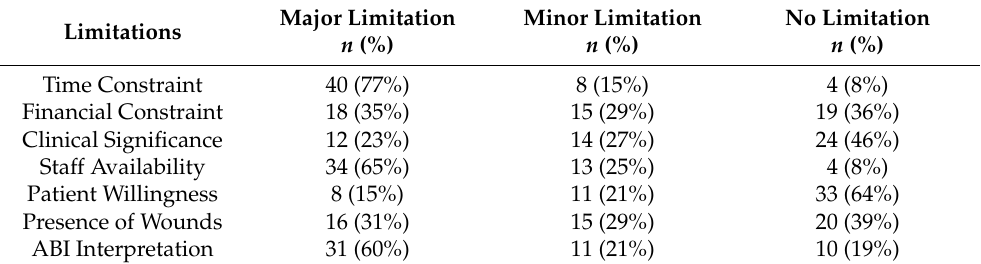
Table 1. Results to the question, “What factors, if any, limit the utilization of the ABI in your clinical practice?” ( n =